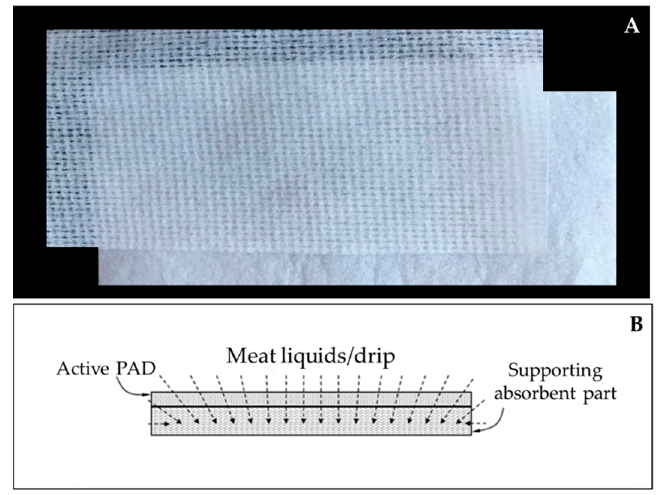
Figure 2. Active absorbent pad ( A ) and scheme of the pad architecture ( B ).